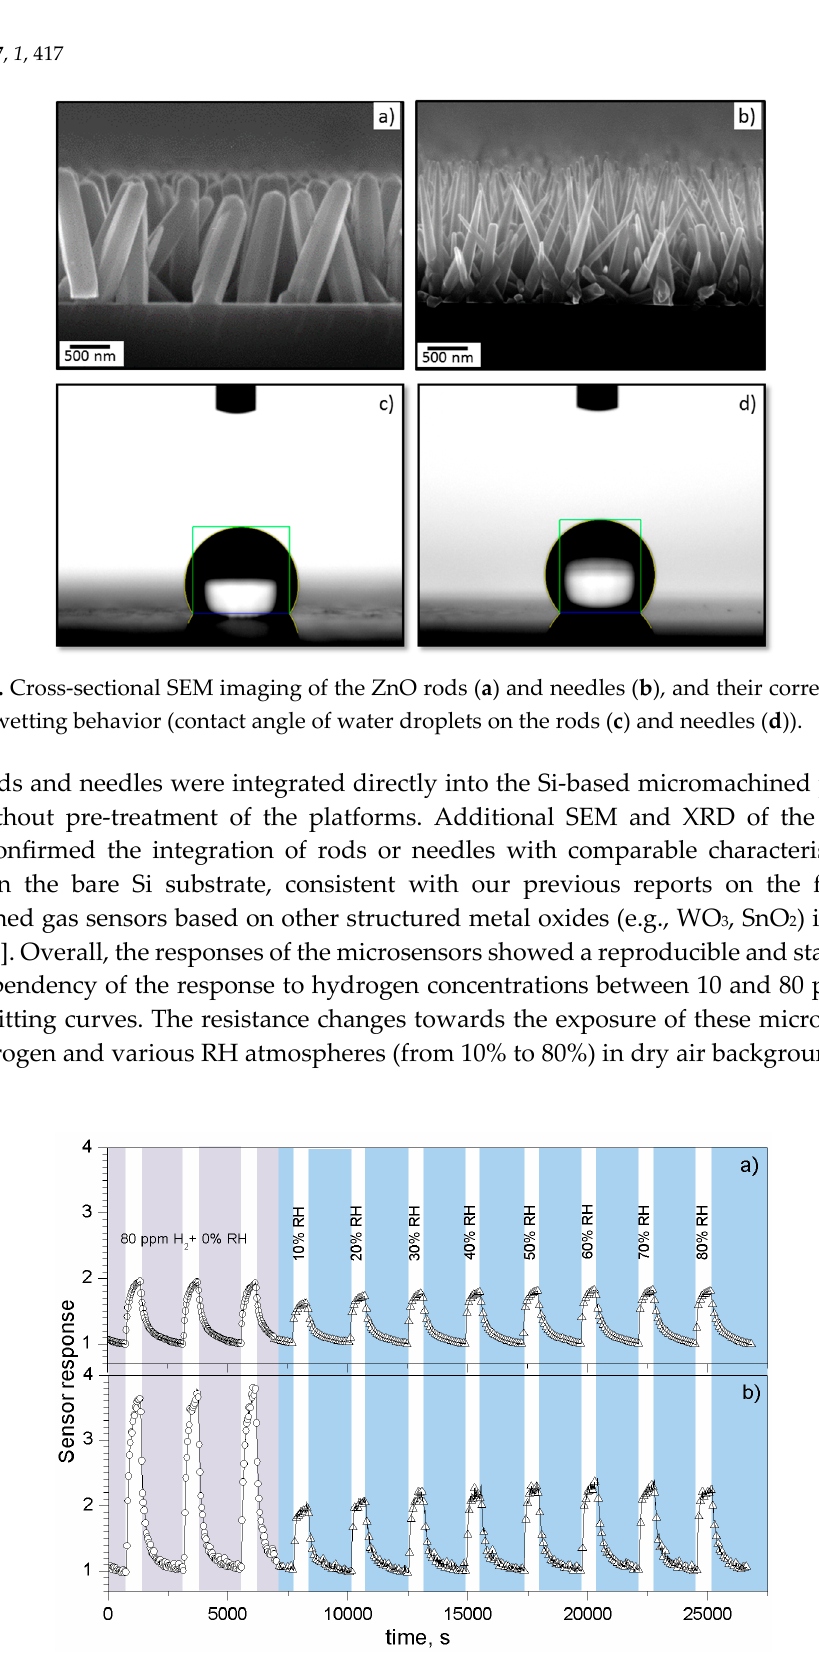
Figure 3. Film resistance changes recorded on the sensors based on ZnO rods ( a ) and needles ( b ) to either H 2 or various RH atmospheres in dry air